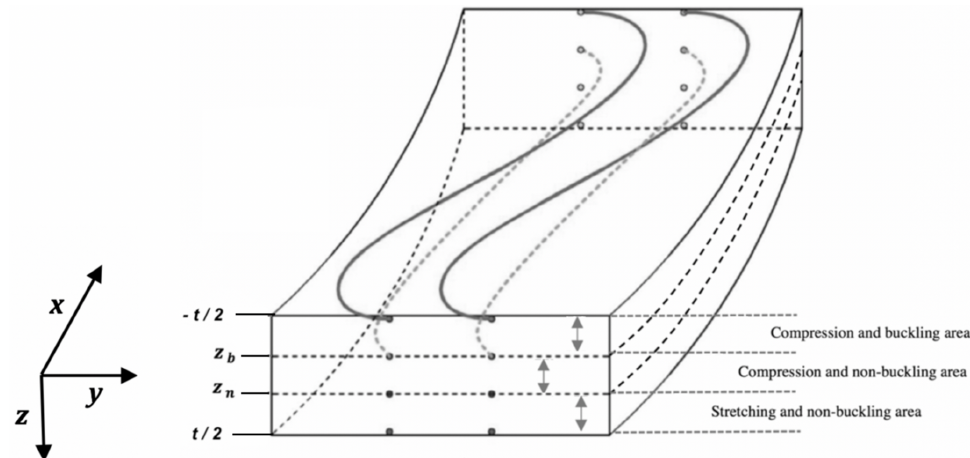
Figure 1: The buckling deformation of fibers in the SMPC plate, here z n and z b denote the neutral strain surface and the critical buckling surface respectively, with the surfaces parallel to the xz surface [31]